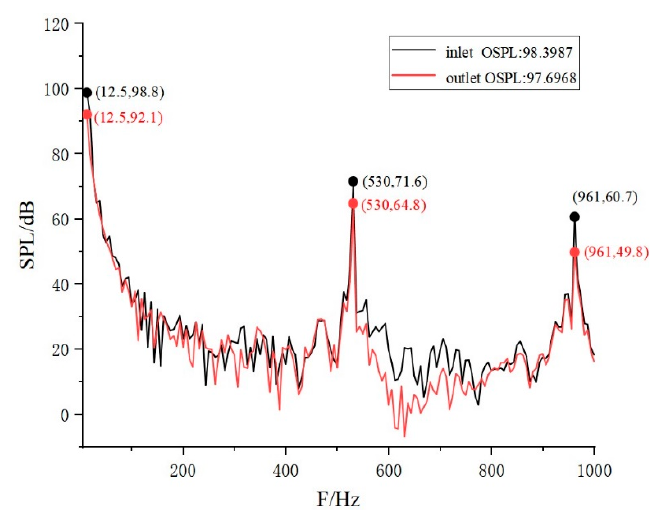
Figure 15. Sound pressure level curve at 145° angle.